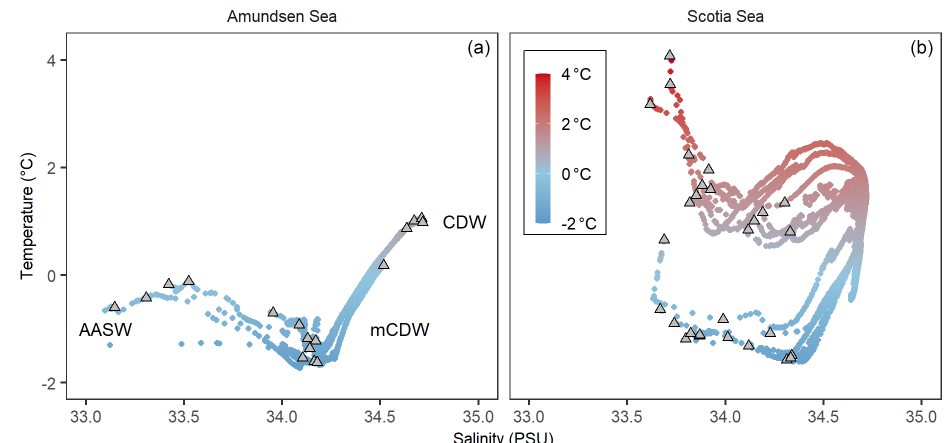
Figure 2. The temperature and salinity profiles ( T – S plot) for the Amundsen Sea (a) showing Antarctic Surface Water (AASW), Circumpolar Deep Water (CDW), and modified CDW (mCDW), and Scotia Sea (b) . Coloured circles indicate the water column temperature of the water masses with the grey triangles indicating the water column sampling depths.